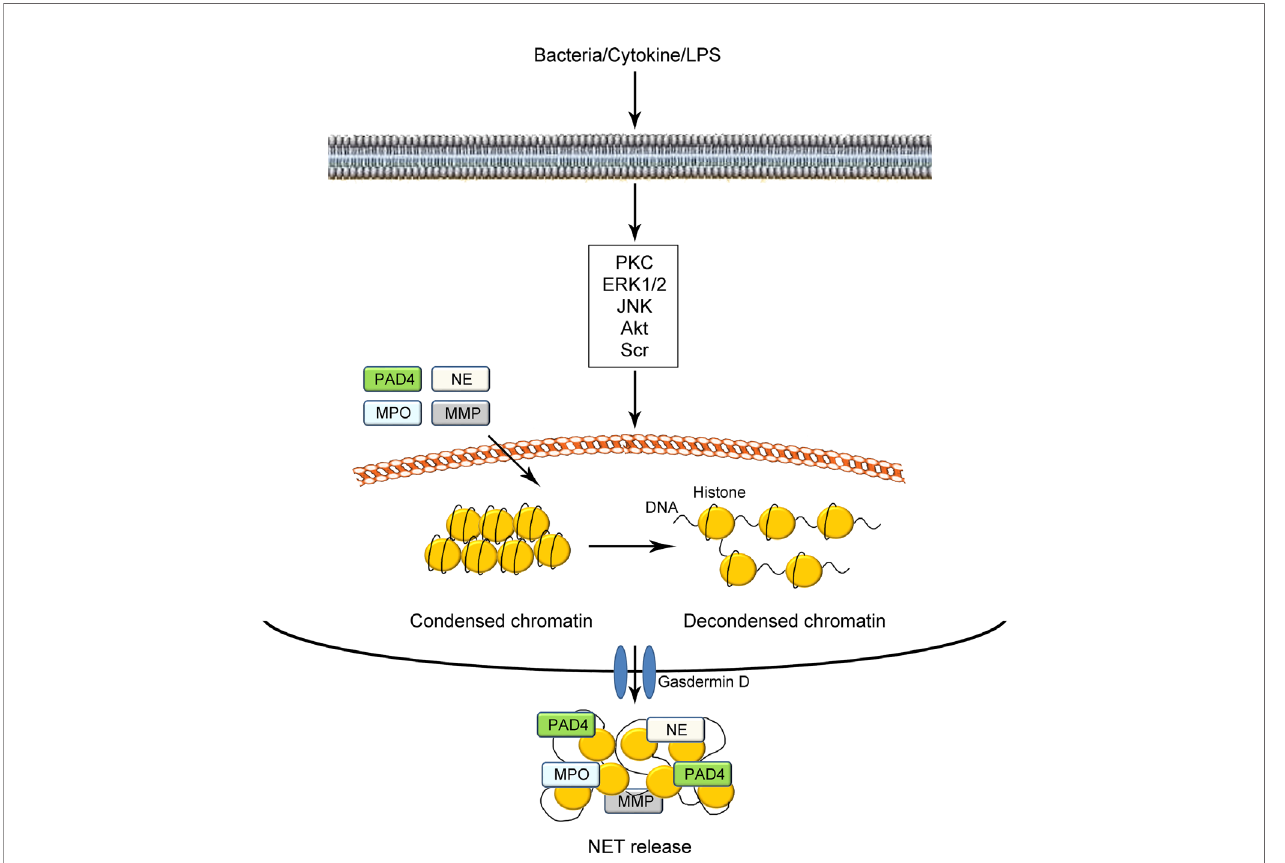
FIGURE 1 | Schematic illustration of NET formation. Under certain stimuli such as bacterial infection, cytokines, and LPS challenge, neutrophils are activated via the modulation of cellular signaling pathways mediated by PKC, EK1/2, JNK, Akt, Scr, and so on. The tight electrostatic binding between DNA strands and histones in nucleosomes is weakened, mediated by two kinds of proteases including PAD4 and NE. The decondensed DNA with citrullinated histones catalyzed by PAD4 are decorated with several granule proteins including PAD4, NE, MPO, MMP, and gasdermin D and expelled from neutrophils as NETs. NETs, neutrophil extracellular traps; LPS, lipopolysaccharide; PKC, protein kinase C; ERK1/2, extracellular regulated protein kinase 1/2; JNK, c-Jun N-terminal kinase; PAD4, peptidyl arginine deiminase 4; MMP, matrix metalloproteinase; NE, neutrophil elastase; MPO,